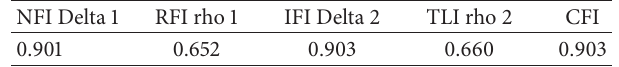
Table 5: Baseline comparisons fit